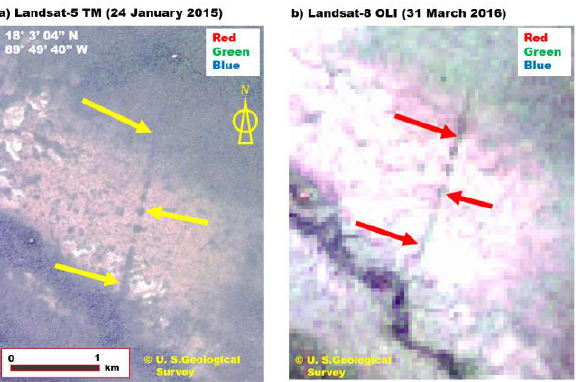
Figure 4. Sacbe segment #7 of Folan et al. (1995) located inside in a bajo , as displayed: a) on a Landsat-5 TM true-colour composite acquired in January 2015; b) on a Landsat-8 OLI true-colour composite made with the image acquired in March 2016.